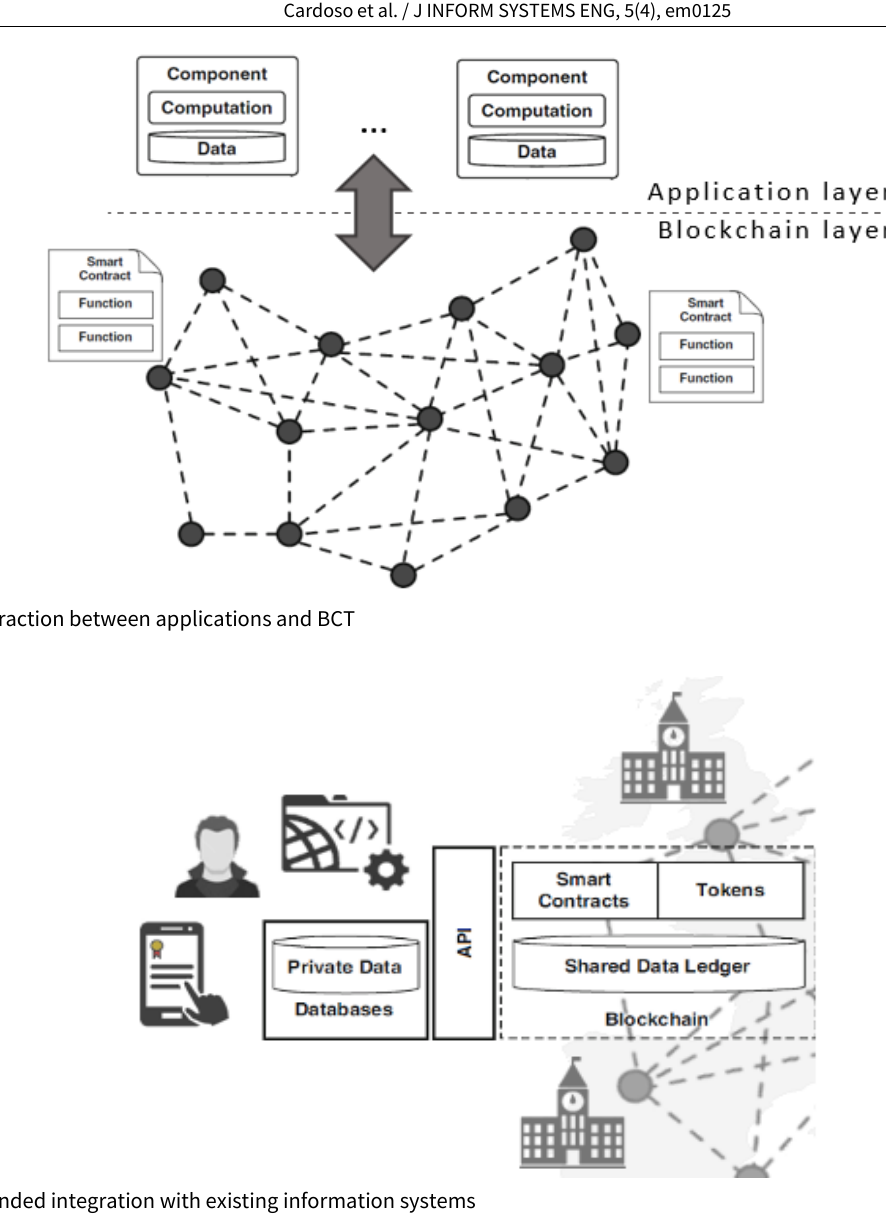
Figure 3. Intended integration with existing information